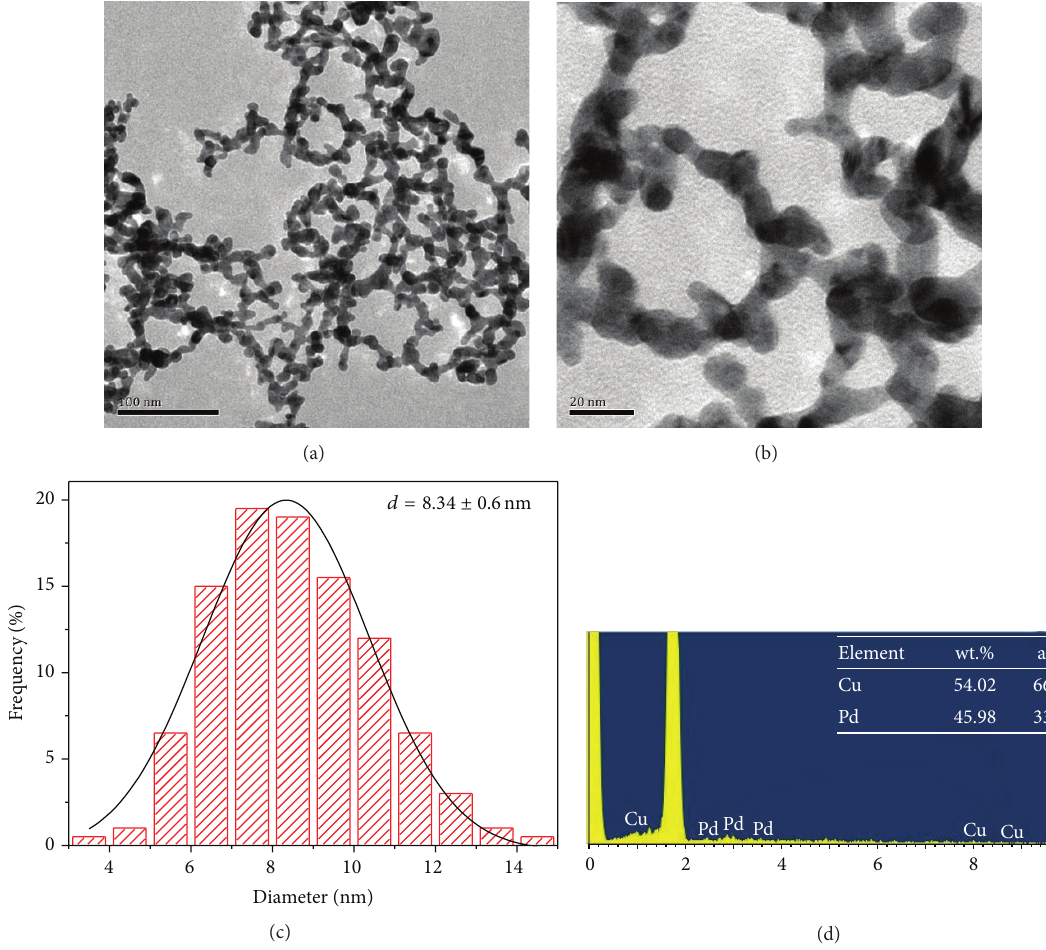
Figure4: (a,b) Typical TEMimages of Pd-Cunanowirenetworks withdifferent magnifications. (c)Particlesizedistributionanalysis. (d) EDS spectrum of the corresponding